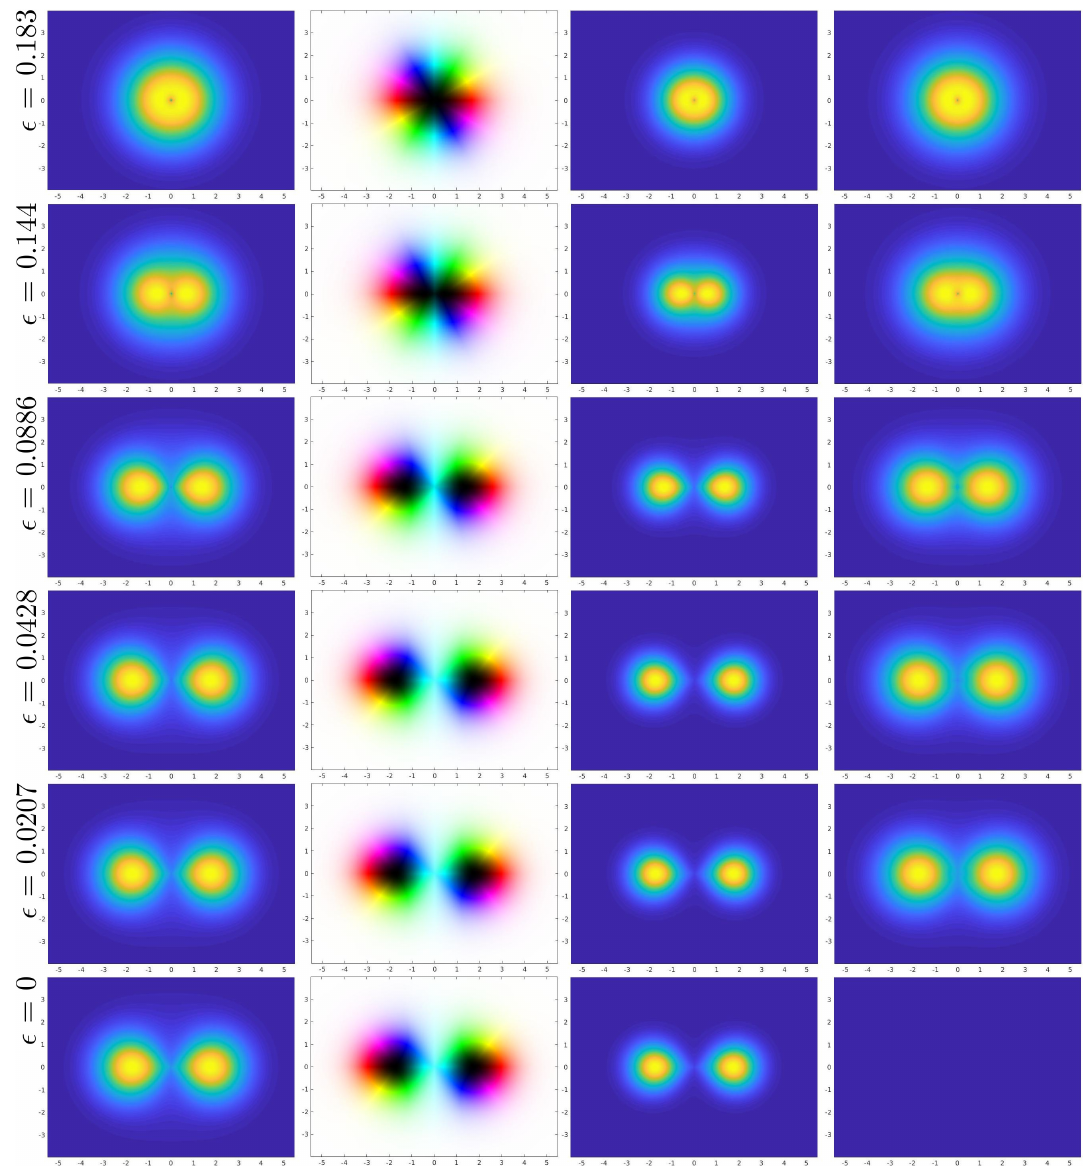
Figure 8. The Q = 1 + 1 baby Skyrmion for various values of (cid:15) . The columns show the topo- logical charge density, the pion vector orientation using a color scheme described in the text, the total energy density and the perturbation energy density (cid:15) ( −L (cid:15) = 0 . 183 ) shows that the solution has decayed into the axially symmetric N = 2 solution. In this figure m = 0 . 5 1